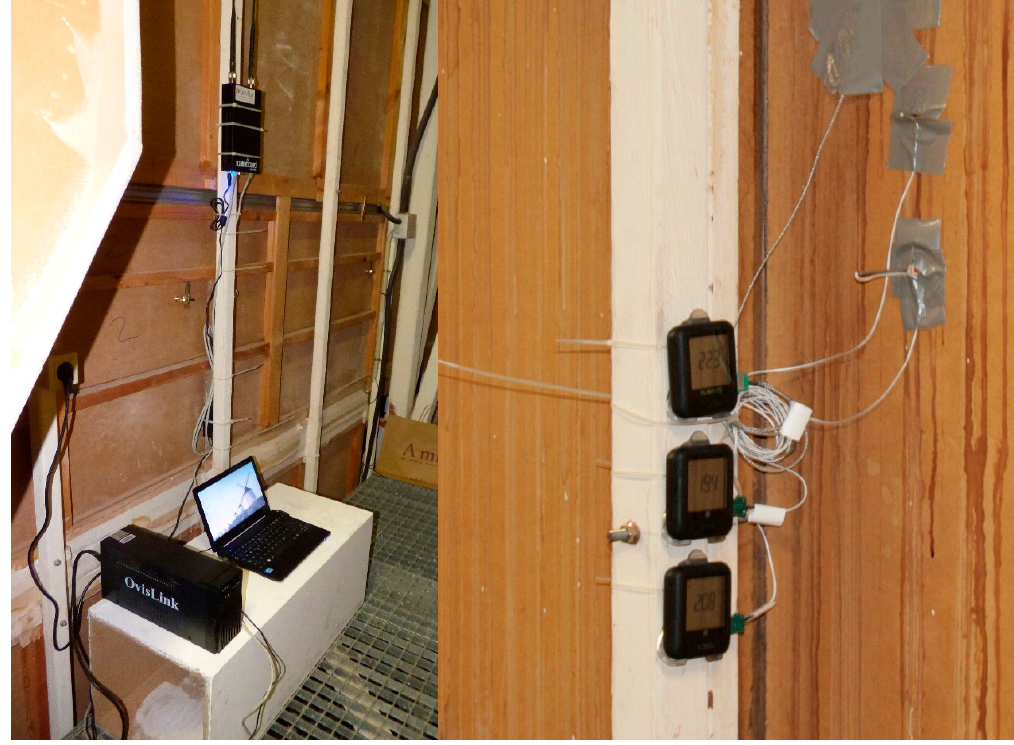
Figure 7. Wireless monitoring system. Reception of the router and data processing laptop.